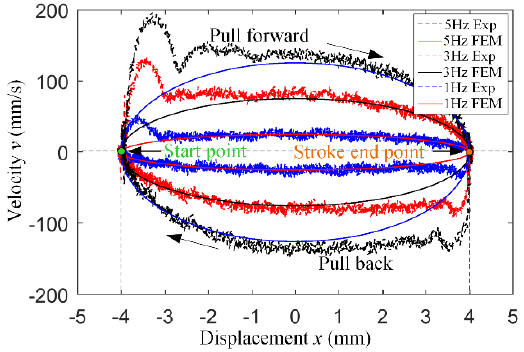
Figure 16. Displacement–velocity curve of the MR buffer.